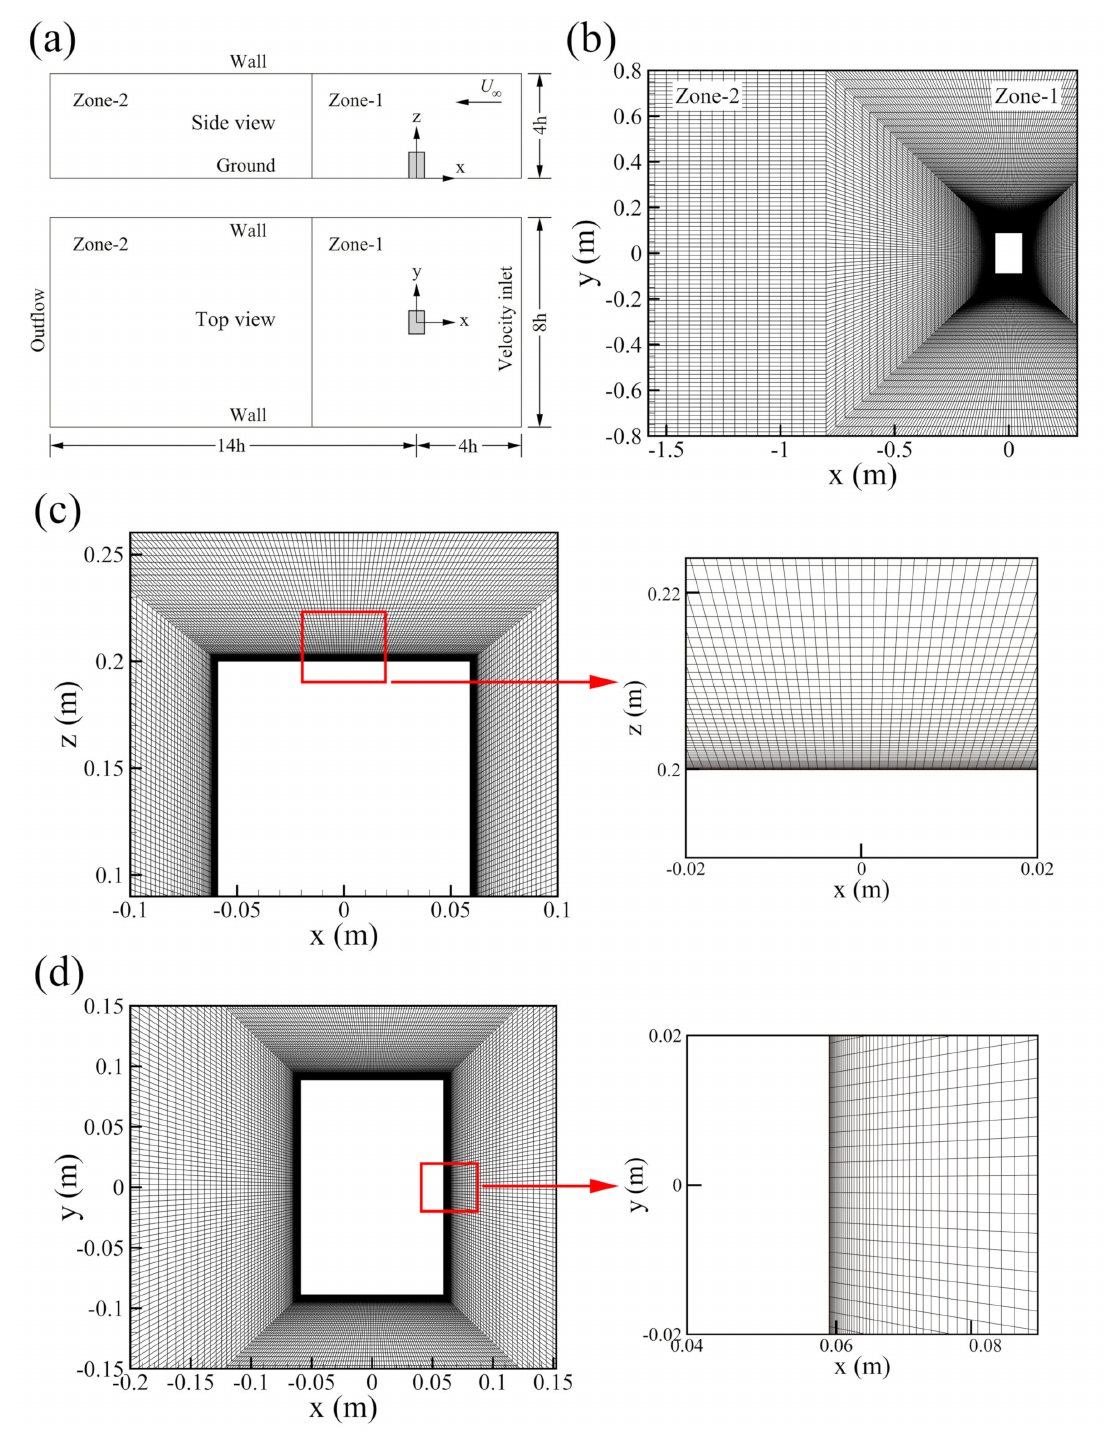
Figure 3. Computational domain and grid arrangement: ( a ) side view and top view; ( b ) grids for each zone; ( c ) grids on the roof surface, where the normalized minimal grid size ∆ z / h is 0.0003; ( d ) grids on the windward wall, where the normalized minimal grid size ∆ z / h is